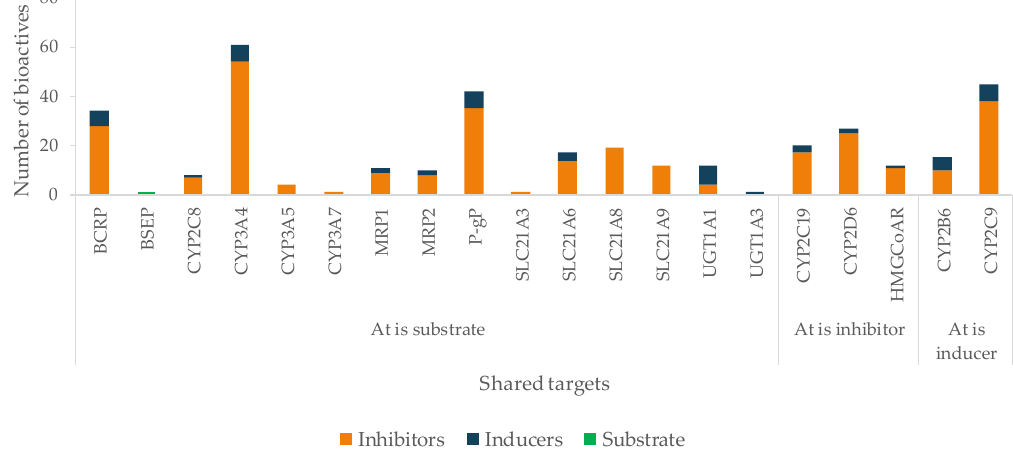
Figure 12. Number of bioactives affecting the shared targets with At and respective mode of interaction (induction/inhibition). For clarity and due to relevance, bioactives were considered as substrates only for BSEP.